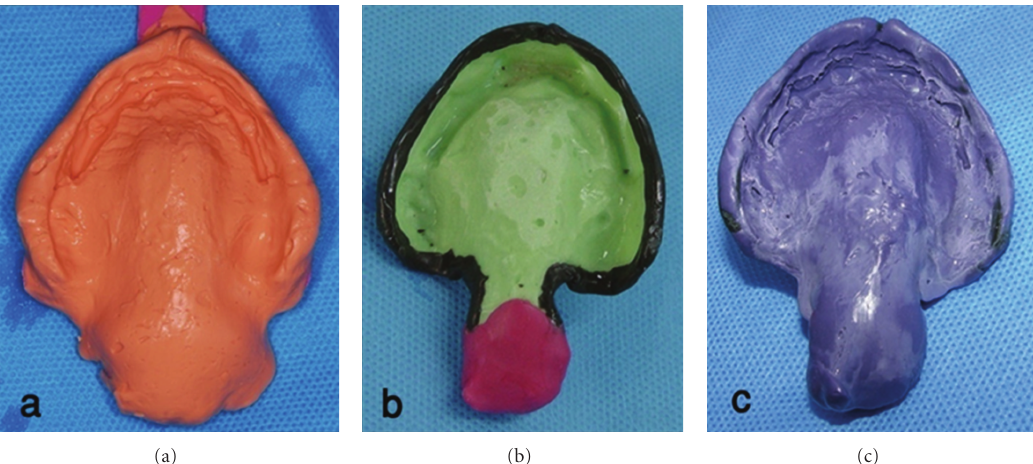
Figure 2: (a) Alginate impression with a prefabricated tray corrected with impression compound for extending to the soft palate site. (b) Maxillary special tray after border molding. (c) Final impression of maxillary arch extending to the soft